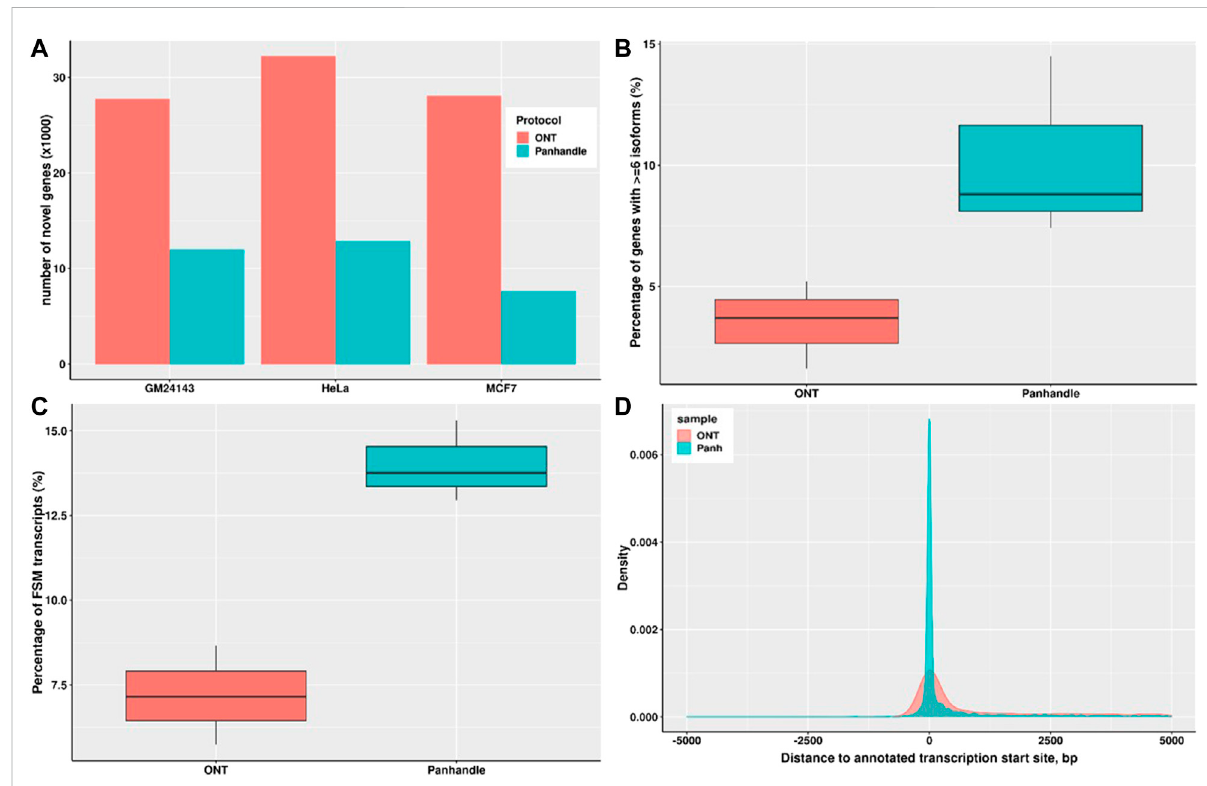
FIGURE 6 Transcriptome comparison between ONT and Panhandle protocols. We used Flair (Tang et al., 2020) to construct a genome-guided transcriptome of 3 cells line; GM24143, HeLa, and MCF7 using reads generated from either Oxford Nanopore Technologies (ONT) protocol SQK- PCB109orourin-houseprotocolnamedPanhandle(orPanh,seeSupplementaryProtocol).Thesixtranscriptomesconstructedwereassessedusing SQANTI (Tardaguila et al., 2018). (A) Total number of novel genes identi fi ed in each transcriptome. (B) Percentage of genes with six or more isoforms. (C) Percentage of transcripts whose splice-pattern (exon structure) is a complete match or full-splice match (FSM) to the GENCODE v35 annotation liftoff to T2T-CHM13 genome assembly (Nurk et al., 2022). (D) Distance of constructed transcripts ’ transcriptional start site (TSS) to their associated annotated transcript TSS. We used MCF7 constructed transcripts in the incomplete splice match (ISM)